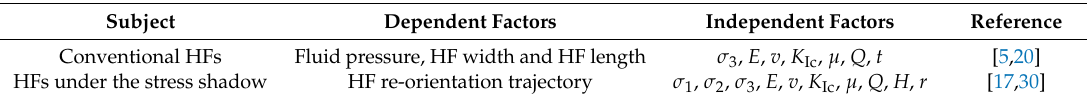
Table 3. Dependent factors and independent factors considered in conventional hydraulic fracturing and HFs under the influence of the stress shadow effect.